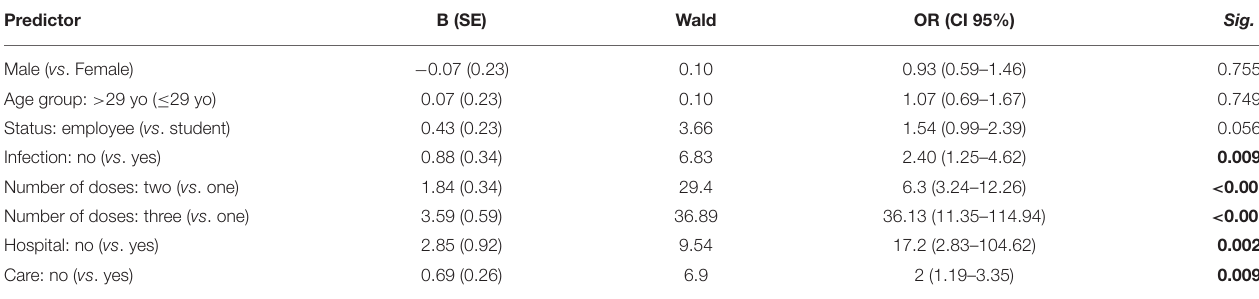
TABLE 7 | Regression analysis of COVID-19 vaccine-related acceptance demographic and anamnestic drivers of German university students and employees participating in the COVID-19 Vaccine Booster Hesitancy (VBH) Survey, december 2021 ( n = 930). Predictor B (SE) Wald OR (CI 95%) Sig.